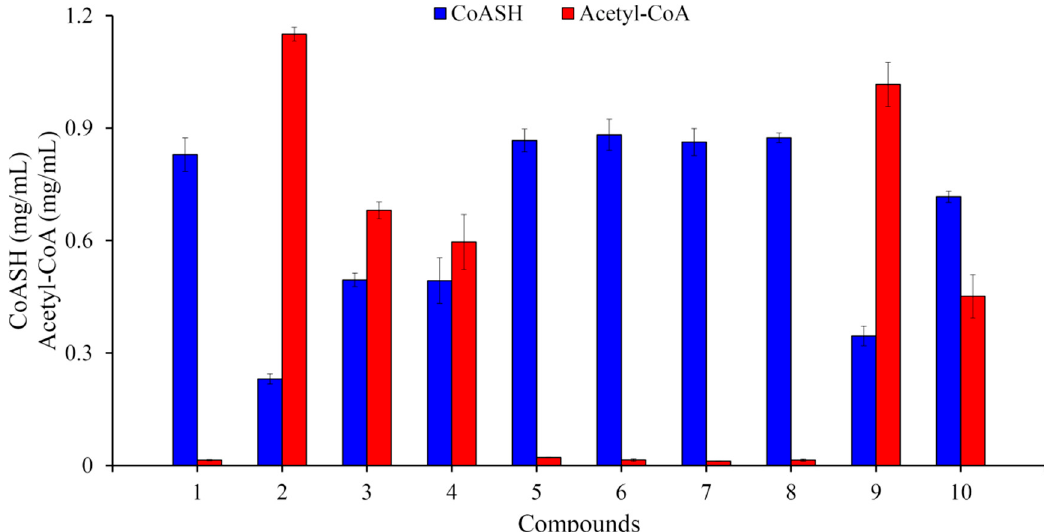
Figure 2. Screening of acetyl donors. 1, Acetylsalicylic acid (ASA); 2, acetylsalicylic acid methyl ester (ASME); 3, acetylsalicylic acid ethyl ester (ASEE); 4, acetylsalicylsalicylic acid(ASSA); 5, benorilate(BL); 6, acetylsalicylic anhydride (ASAN); 7, DL-lysine acetylsalicylate (DLA); 8, carbasalate calcium (CSC); 9, acetyl-trans-resveratrol (ATR); 10, 4-acetoxyacetanilide(AOA). The data represent the means ± SD, n = 3.